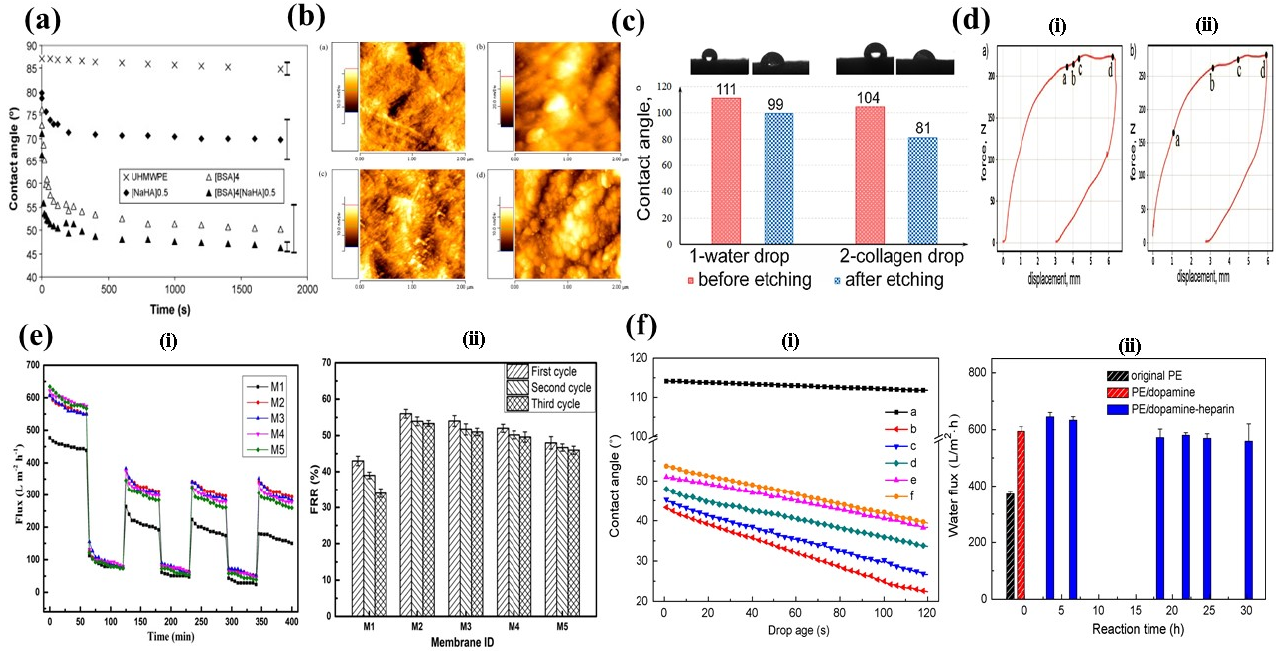
Figure 10. ( a ) Water contact angle of UHMWPE before and after protein incubation. Reprinted with permission from [19]. ( b ) AFM images of UHMWPE with or without protein incubation; ( a ) pure UHMWPE; ( b ) after incubation in BSA solution; ( c ) after incubation in NaHA solution; ( d ) after incubation in both solutions. Reprinted with permission from [19]. ( c ) Water contact angle of treated and untreated UHMWPE after surface treatment. Reprinted with permission from [145]. ( d ) The force displacement curve of three-point bending test for (i) freeze-dried collagen hybrid; (ii) collagen-HAp hybrid. Reprinted with permission from [145]. ( e ) Antifouling properties of different membranes (M1, M2, M3, M4, and M5): (i) variation of time-dependent flux over three periods with bovine serum albumin (BSA) as a pollutant; (ii) values of FRR with BSA as a pollutant. Reprinted with permission from [70]. ( f ) Contact angle vs. drop age curves for the original and modified PE porous membranes: (i) untreated PE membrane; (ii) PE-polydopamine composite membrane; ( c – f ) PE/dopamine-heparin composite membrane; ( b ) impact of heparin immobilization period for PE membranes on water flux. Reprinted with permission from